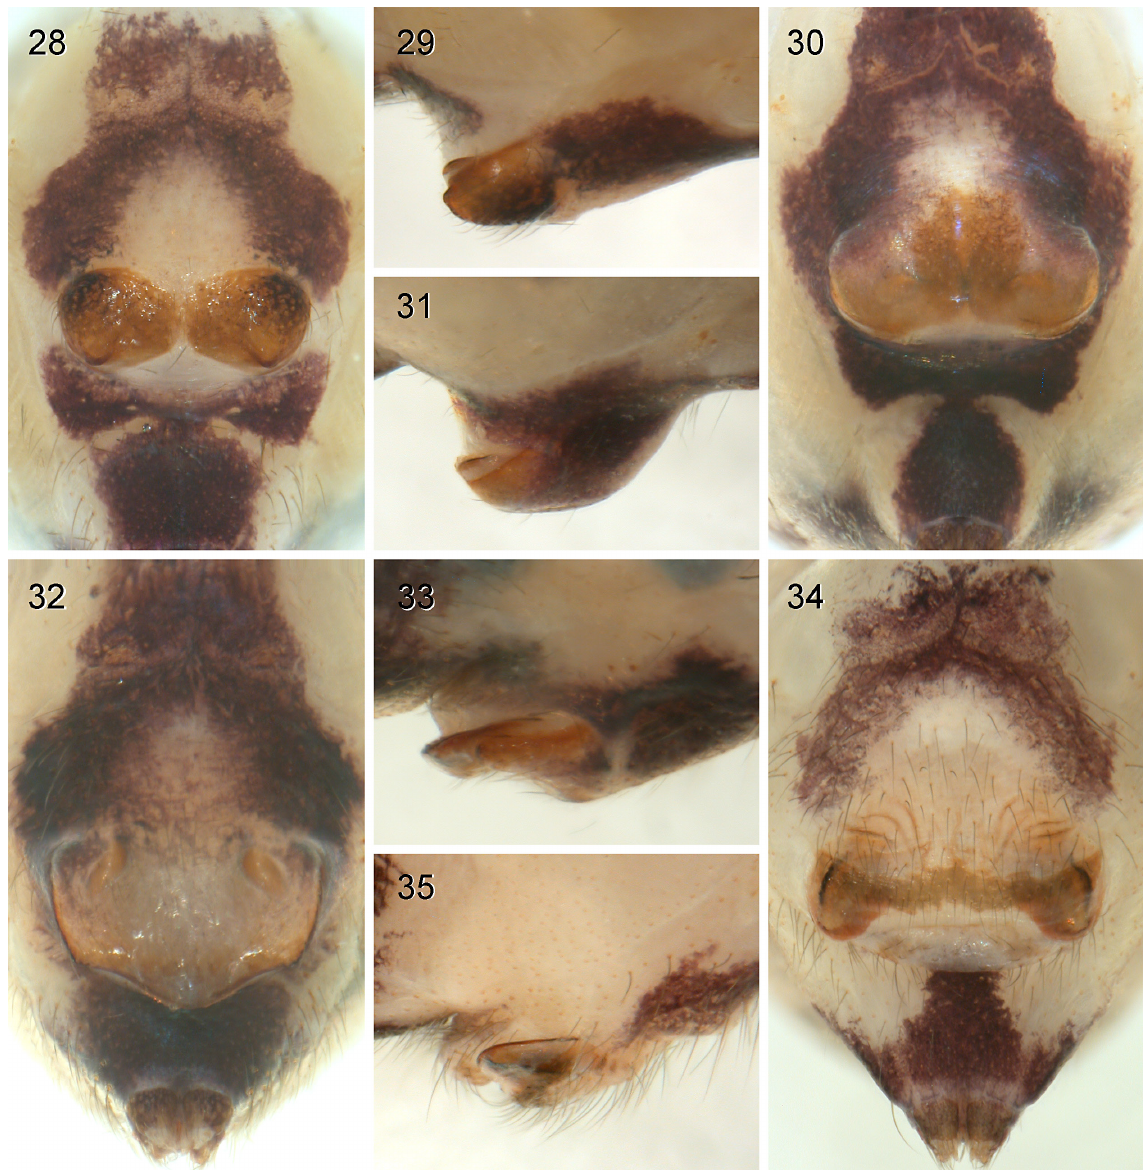
Figs 28–35. Epigyna, ventral and lateral views. — 28–29 . Savarna kaeo sp. nov. — 30–31 . S. thaleban Huber, 2005. — 32–33 . S. tessellata (Simon, 1901). — 34–35 . S. miser (Bristowe, 1952). At varying